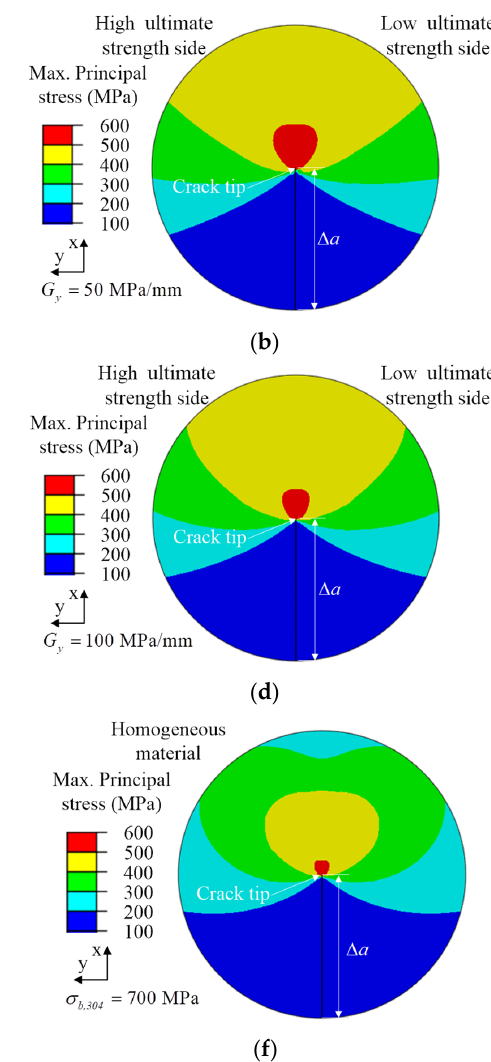
coefficients of crack propagation length ∆ a = 0.6 mm in the y-direction. ( a ) G y = − 50 MPa/mm, ( b ) G y = 50 MPa/mm, ( c ) G y = − 100 MPa/mm, ( d ) G y = 100 MPa/mm, ( e ) σ b,316L = 600 MPa, ( f ) σ b,304 = 700